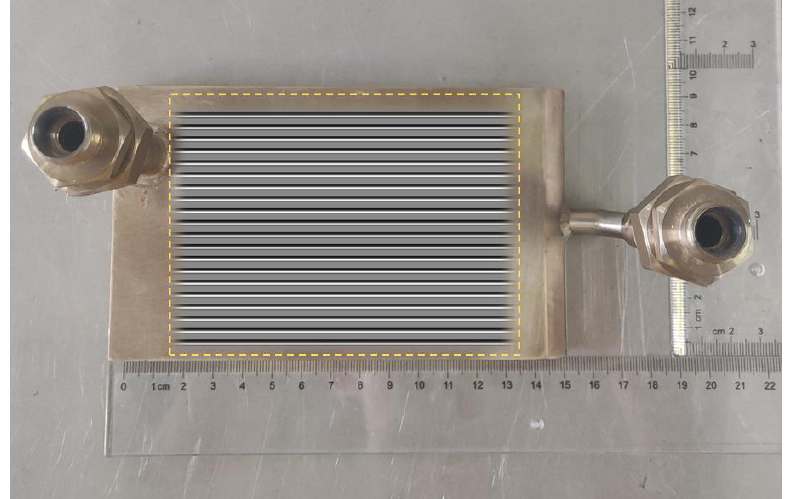
Figure 3. Single-plate test PCHE prototype with straight channels.